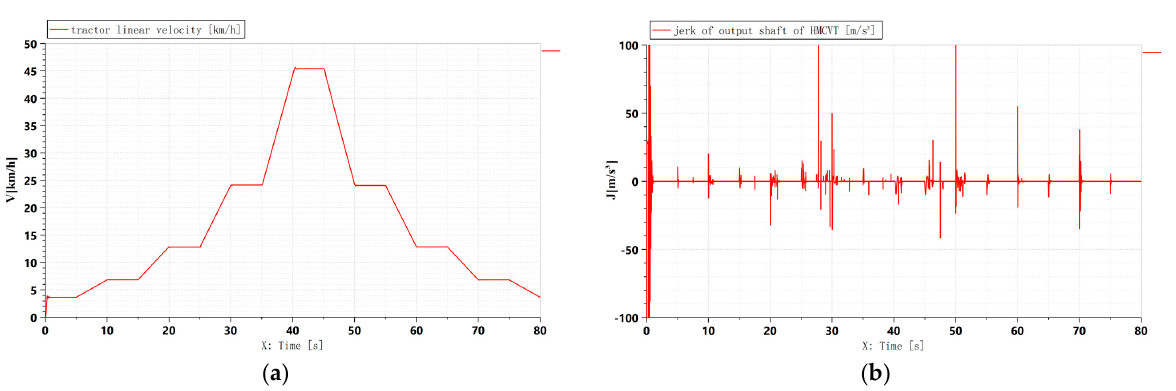
Figure 5. Powertrain simulation model.